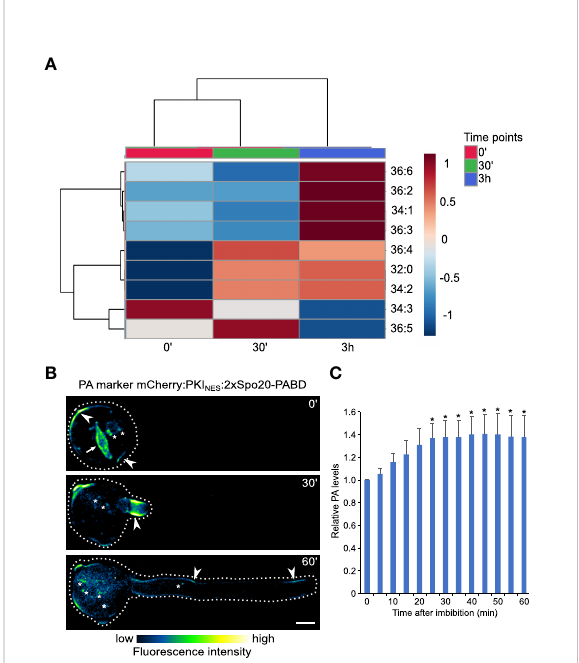
FIGURE 8 Distinct PA pools are mobilized during pollen germination and pollen tube growth. (A) Heatmap showing the correlation among phosphatidic acid (PA) species of germination and elongation of pollen tube samples. Data of the % of total signal of each species (identical to the data presented on Fig. 3) were normalized and analyzed using Spearman rank correlation analysis within MetaboAnalyst. Each colored cell on the map indicates the correlation coef fi cient, with the scale code shown on the top right corner. Blue and red colors on the heatmap indicate negative and positive correlations, respectively for increasing and decreasing species abundance relative to the mean of the 3 sample groups in the row for the 0 ’ , 30 ’ and 3h sets, respectively; the color tint indicates fold-changes up to one and down to -1. The white color stands for no change, and gray for not detected. (B) During pollen germination and tube elongation, genetically-encoded PA markers relocalizes between different regions of pollen plasma membrane (arrowhead), nuclear membranes (arrow) and endomembranes (asterisk). Spinning disk confocal imaging (average Z-projections) of germinating tobacco pollen stably expressing PA marker mCherry-NES- 2xSpo20-PABD under the control of UBQ10 promoter. Pollen was imaged at indicated times after imbibition and a cell exhibiting typical localization pattern (n=12) is shown. (C) Quantitative microscopic analysis of PA levels across all cellular pools during pollen germination and growth. Total fl uorescence levels of PA marker were measured in ROIs encompassing the whole cell (dashed line) at indicated times after pollen imbibition. Relative fl uorescence (normalized to time 0) is shown as mean ± SE (n=12 from three independent experiments), asterisk indicates time points different from time 0 (one-way Anova followed by Dunnet ’ s test, p